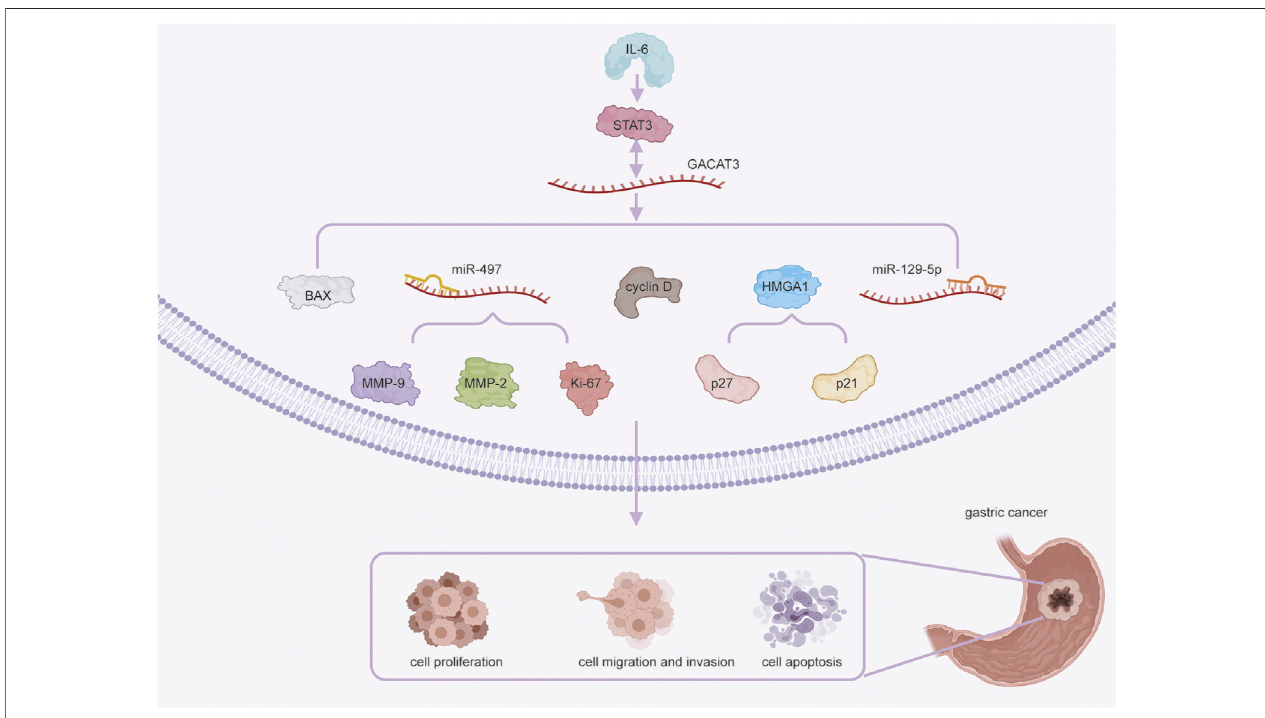
FIGURE 1 | GACAT3 in gastric cancer (GC) cell proliferation, migration, invasion, and apoptosis. GACAT3 regulates cell proliferation in GC through multiple mechanisms. First, GACAT3 competitively interacts with miR-129-5P. GACAT3 also interacts with miR-497 to induce Ki-67 expression. Additionally, GACAT3 modulates the expression of HMGA1 and the levels of p27 and p21. Finally, GACAT3 upregulates cyclin D expression via IL6/STAT3 signaling. GACAT3 exerts its pro-migratory and pro-invasive effects by sponging miR-497 to downregulate the expression of MMP-2 and MMP-9. GACAT3 promotes cell apoptosis by upregulating STAT3 expression and decreasing the level of BAX.